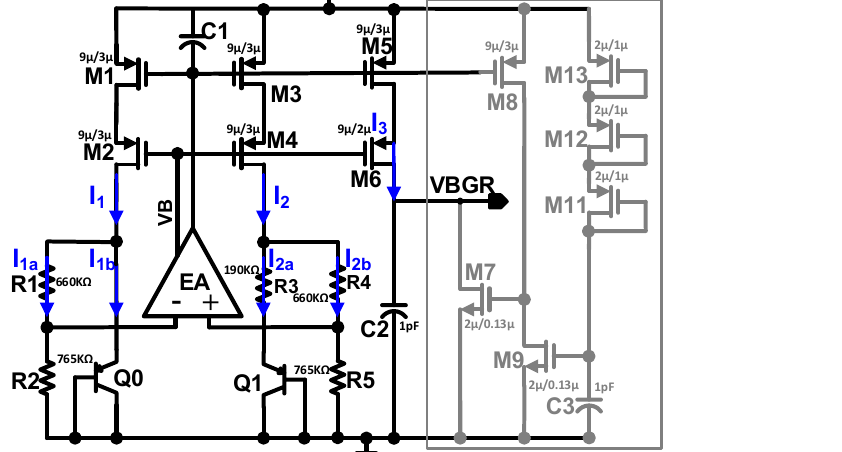
Sensors 2022 , 22 , x FOR PEER REVIEW Figure 10. Schematic of BGR. Figure 10. Schematic of BGR.